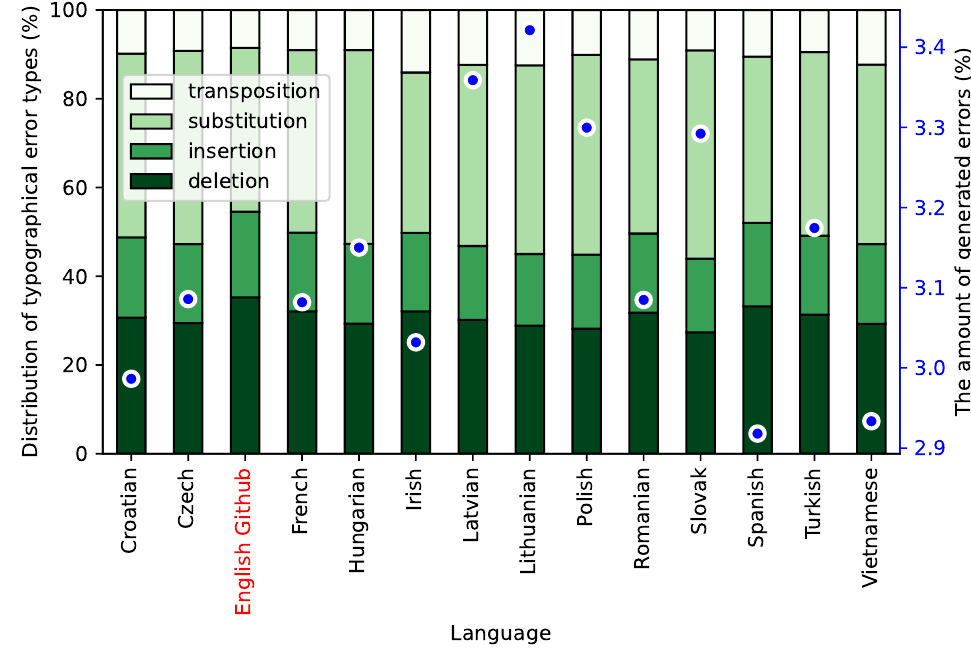
Figure 1. Distribution of generated typographical errors by category (the left vertical axis and stacked bars). Proportions for the English part of the GitHub Corpus (used to derive generation probabilities) are also depicted for reference. The total percentage of induced corruptions are included (the right vertical axis and corresponding blue